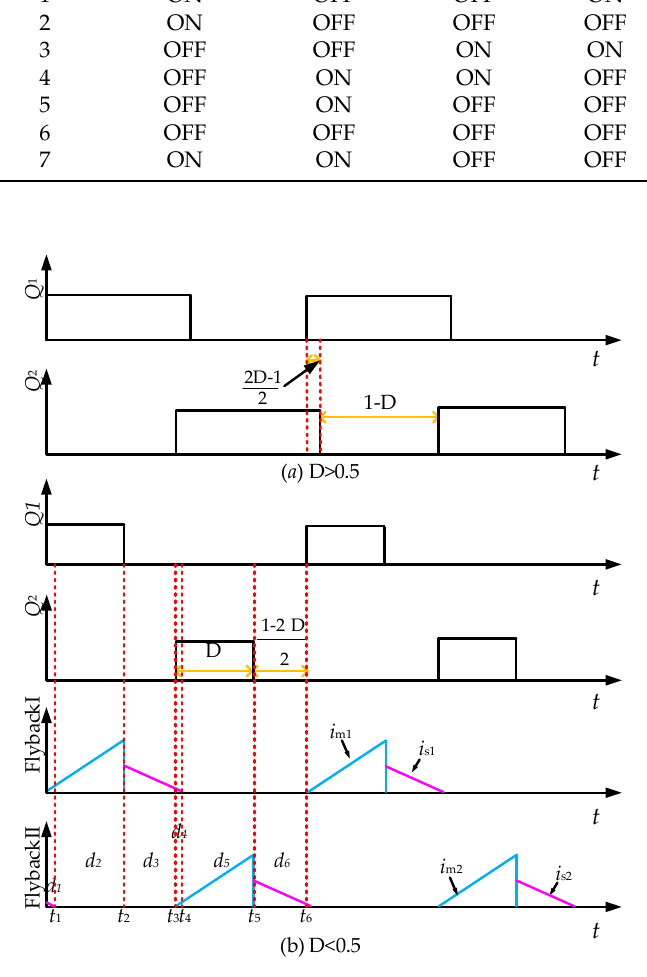
Figure 2. PWM and duty cycle for one switching period and the waveforms of i m 1, i s 1 , i m 2 , and i s 2 corresponding to switch Q1, Q2 and Duty cycle state.